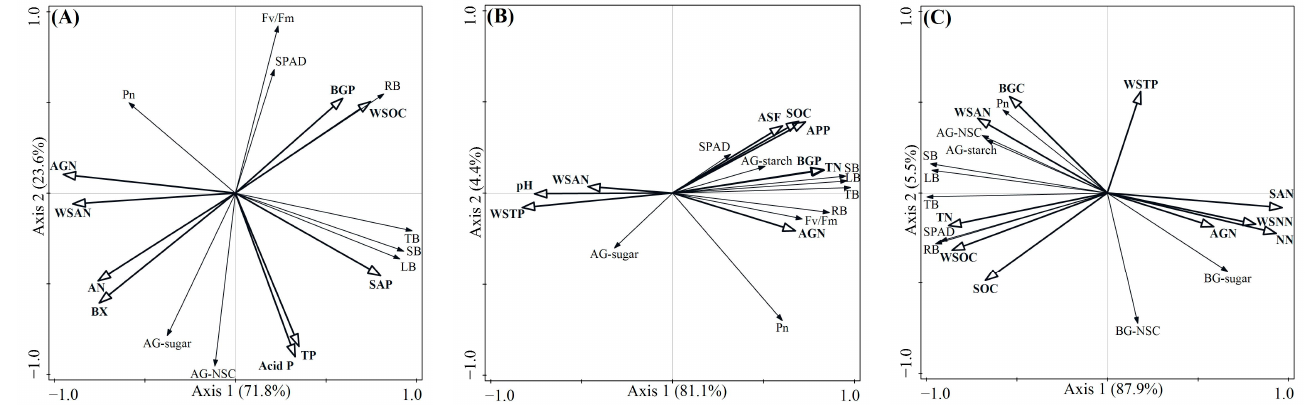
Figure 6. Bidimensional graphs from redundancy representing the relationship between the func- tional traits of early- ( A ), mid- ( B ), and late-successional species ( C ) and soil fertility factors. AGN plant aboveground N, BGC plant belowground C, BGP plant belowground P, LB leaf biomass, SB stem biomass, RB root biomass, TB total biomass.